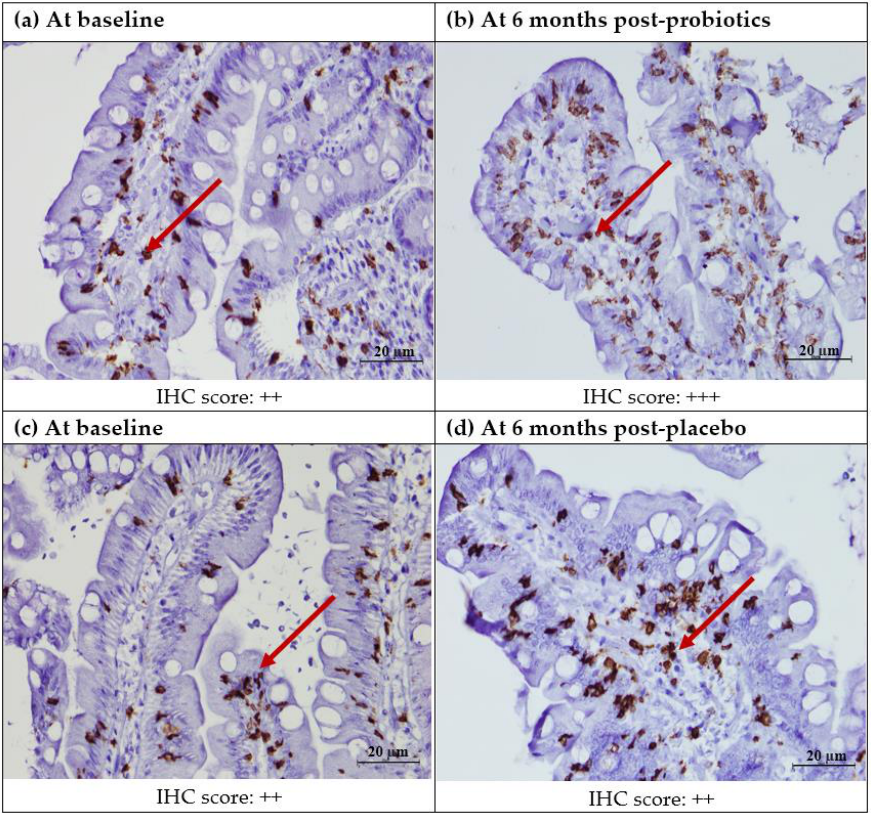
Figure 4. Immunohistochemical staining of CD8+ protein in the duodenal mucosa (CD8+,400X). ( a ) Duodenal mucosa of a patient with NAFLD at baseline. ( b ) Duodenal mucosa of a patient with NAFLD after 6 months of probiotics. ( c ) Duodenal mucosa of a patient with NAFLD at baseline. ( d ) Duodenal mucosa of a patient with NAFLD after 6 months of the placebo. Red arrows show brownish CD8+ T lymphocytes in the lamina propria. Semi-quantitatively, no significant post-intervention difference was seen in either the probiotics of placebo groups. Staining score: 0: no staining; +: focal staining; ++: regional staining; and +++: no loss.